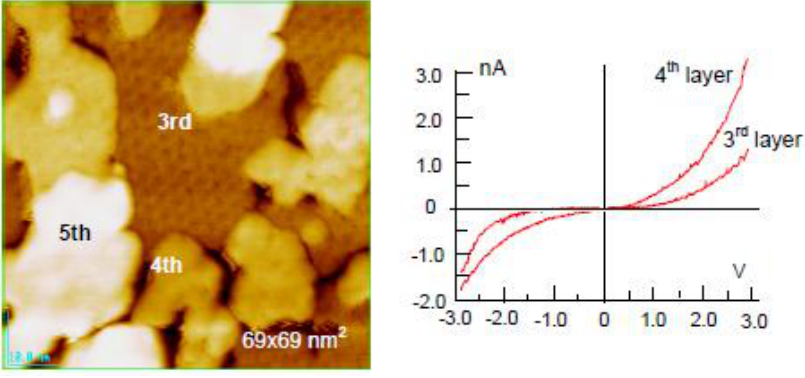
Figure 19. The 3rd supra-honeycomb layer has a band gap but the 4th and 5th Zn layers are metallic on a Si(1111)-7 × 7 surface